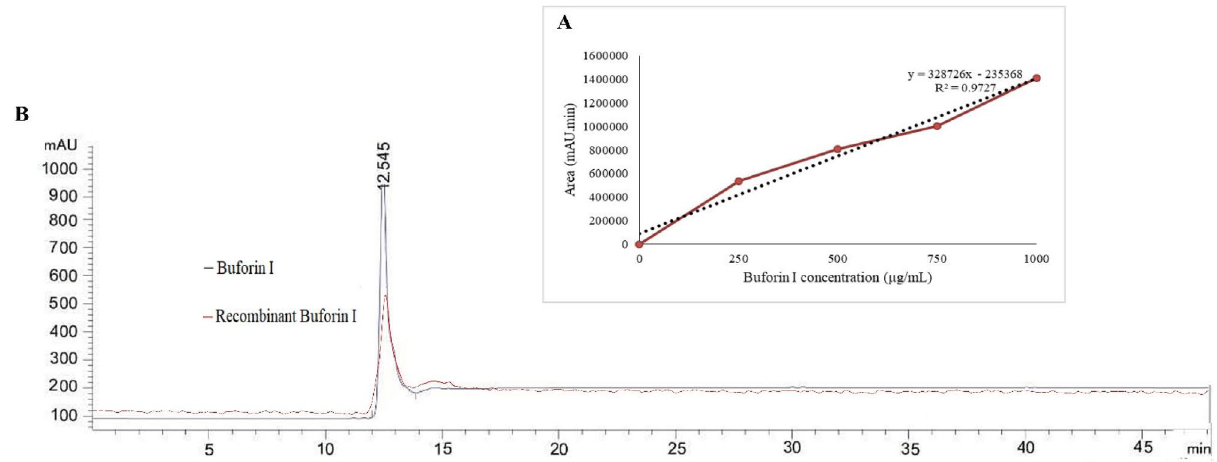
Figure 7. ( A ) Calibration curve with a R-squared value of 0.97 (dashed line) for the buforin I concentration range of 0–1000 µg/mL (data points are given as filled circles); ( B ) Analytical HPLC of recombinant and synthetic buforin I indicating purity of recombinant